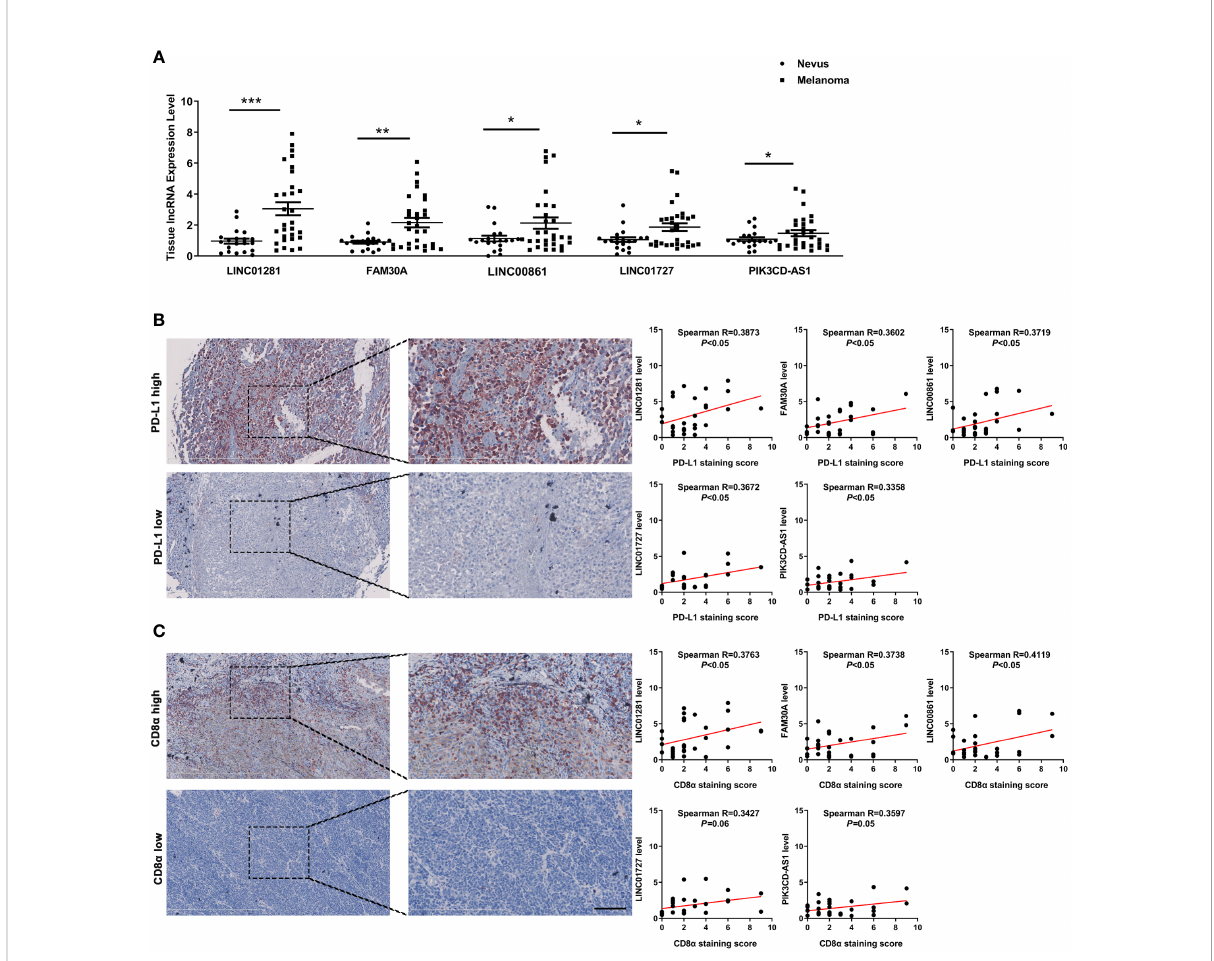
FIGURE 7 (A) The expression of fi ve DEfrlncRNAs in melanoma tissues and nevi. (B, C) Correlation analysis between the fi ve DEfrlncRNAs and PD-L1/CD8 a in melanoma tissues. The Spearman correlation was used to calculate the r value. *p < 0.05, **p < 0.01, ***p <